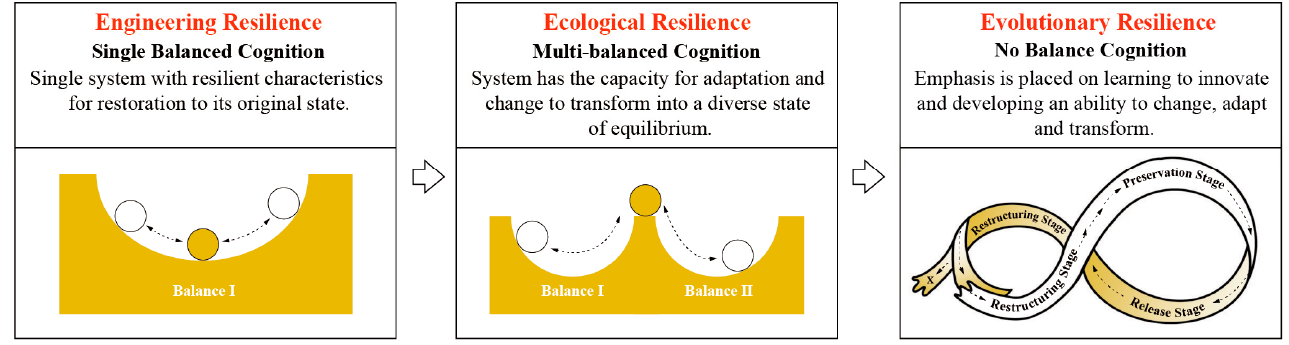
Figure 6. Engineering resilience–ecological resilience–evolutionary resilience evolutionary